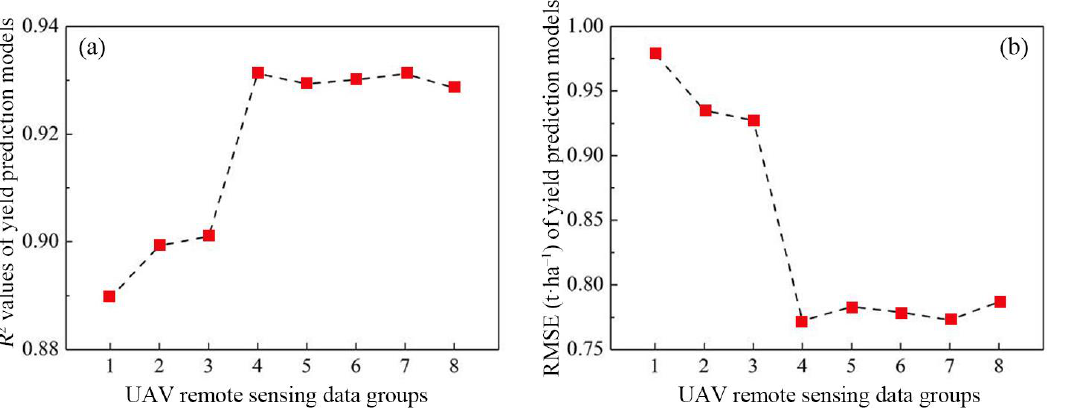
Figure 8. Yield prediction accuracy using different multi-temporal UAV data: ( a ) R 2 and ( b ) RMSE (t·ha − 1 ) values.